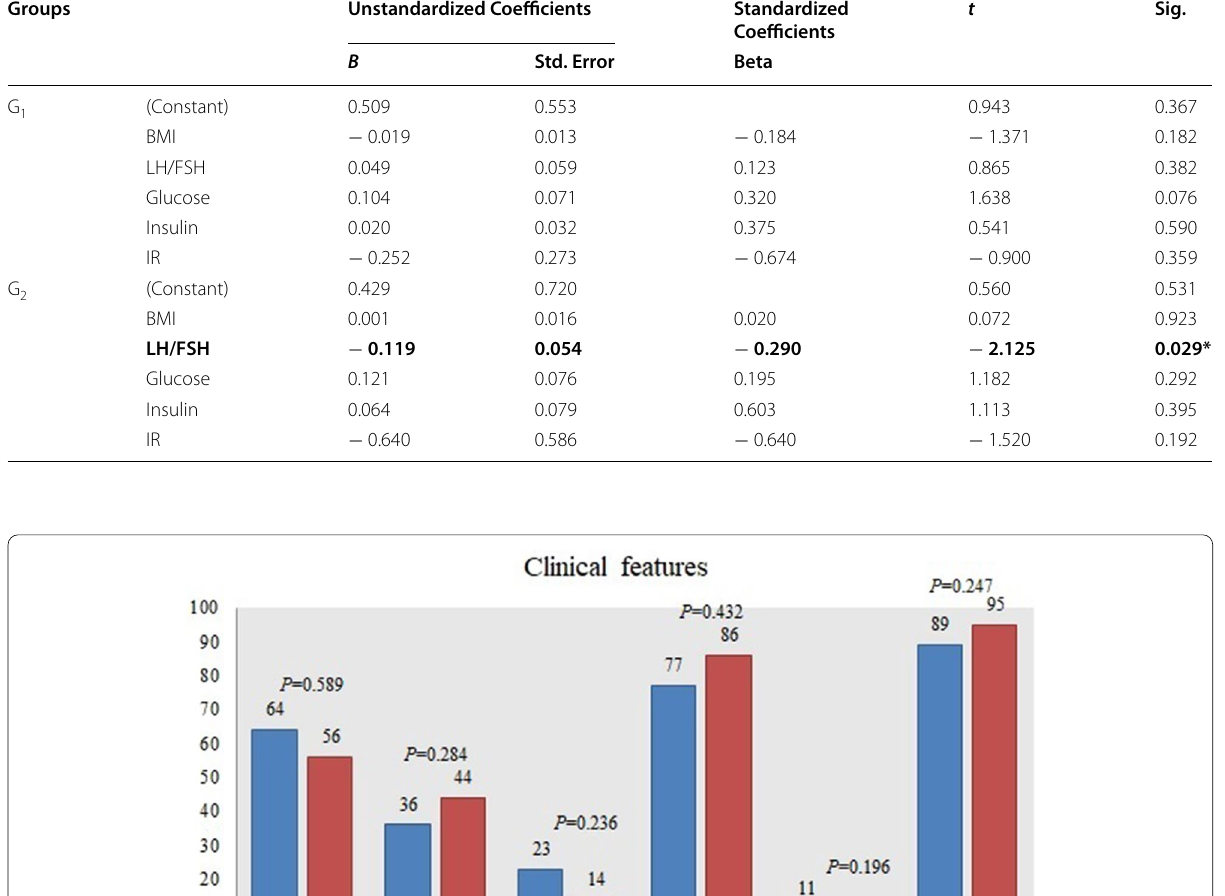
Table 4 Regression model for normal menstrual cycles compared to independent variables Groups